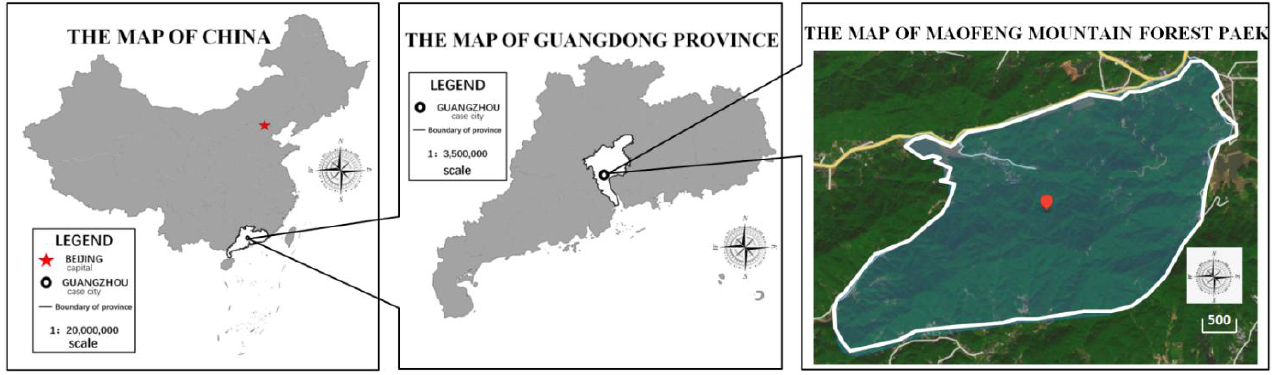
Figure 1. Geographical location of Maofeng Mountain Forest Park in Guangzhou.